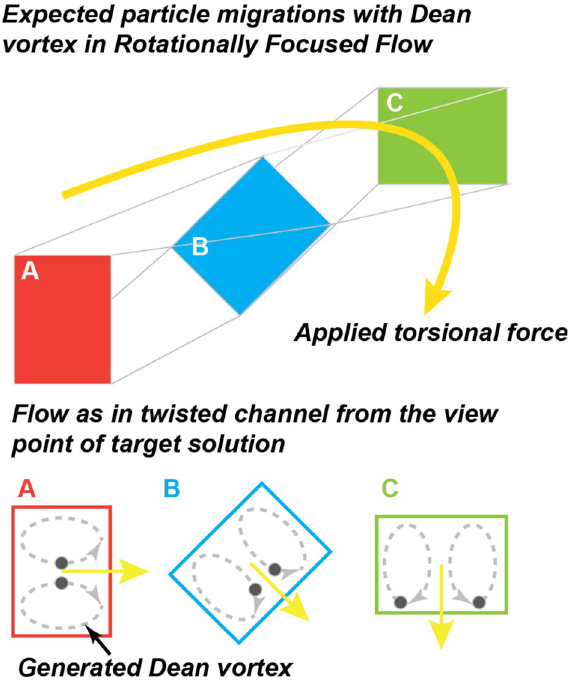
Figure 7. Schematic diagram of Dean vortex in RFF at target fluid point of view. Particle migrations by the Dean vortex are illustrated based on microchannel positions in Fig. 3a ( A : position 2–3, position B : 3–5, position C :